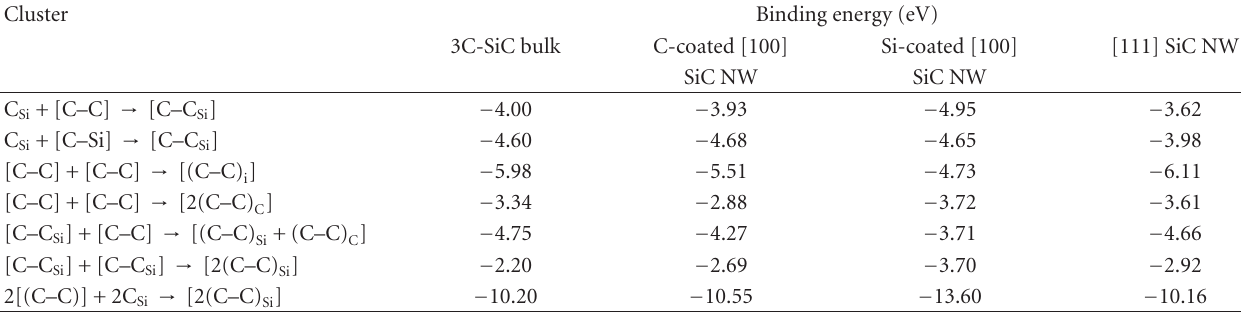
Table 2: Binding energies (in eV) of C defects in 3C–SiC bulk, and hydrogen-passivated [100] and [111] SiC NWs. In each column the values correspond to the stoichiometric